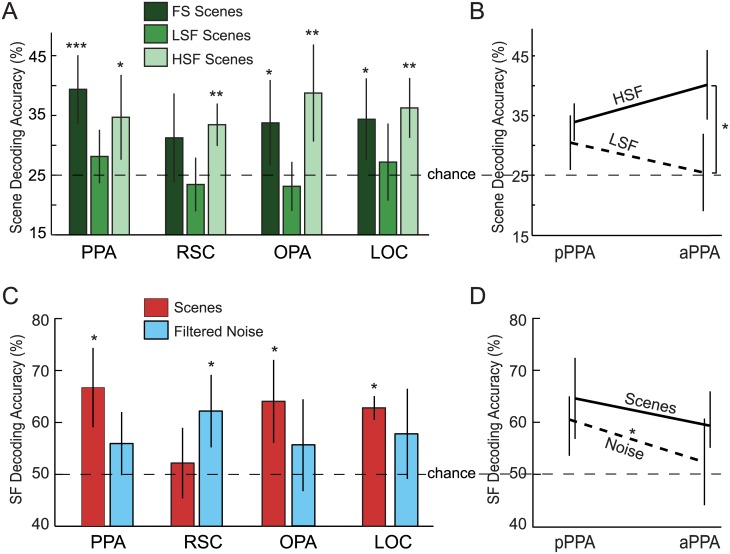
Multivariate decoding results.(A) Decoding of scene categories (4-way classification) is as accurate for HSF as for FS scenes. LSF scenes, on the other hand, cannot be decoded above chance. (B) Dividing the PPA along the A-P axis, reveals similar decoding accuracy for HSF and LSF scenes in posterior PPA, but significantly higher accuracy for HSF than LSF in anterior PPA. (C) Decoding of high versus low spatial frequencies from scene stimuli succeeded in PPA, OPA, and LOC but not the RSC. Decoding of spatial frequency from filtered noise stimuli succeeded only in RSC. (D) Decoding of spatial frequency was more accurate from the posterior than the anterior subdivision of the PPA. This difference was statistically significant for noise images but not for scenes. Error bars represent standard errors of the mean. *p < 0.05, **p < 0.01, ***p < 0.001; N = 10.